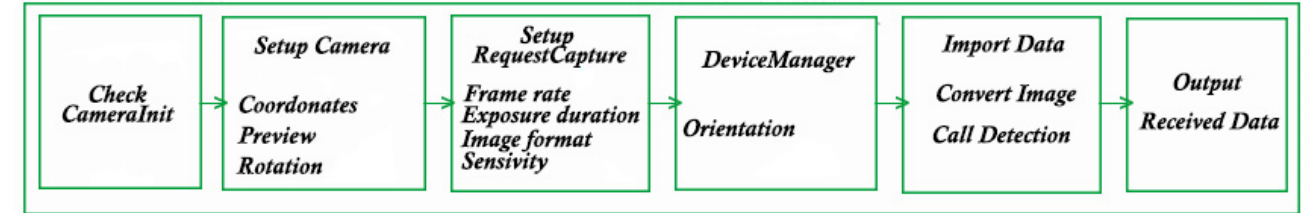
Figure 5. Dedicated OCC processing software architecture through the OpenCV library.